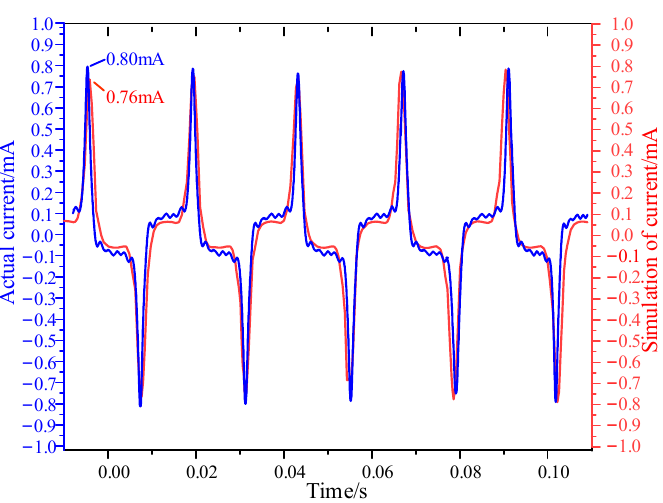
Figure 14. Simulation and actual current under 34 kV continuous voltage.